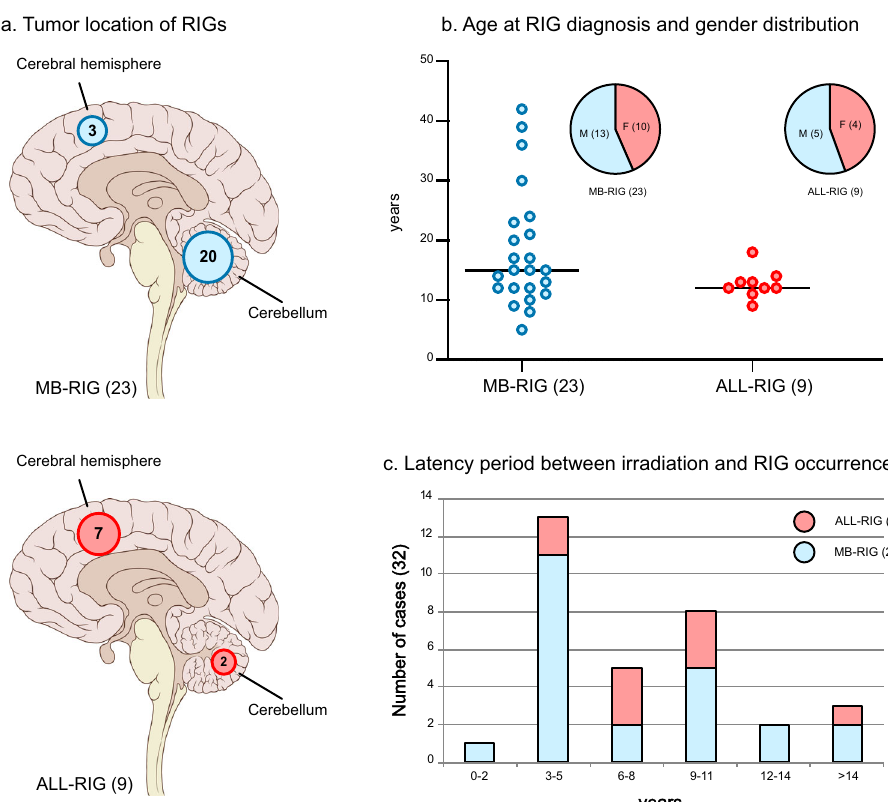
Fig. 1 Clinical patient characteristics. Tumor location for 23 MB-RIG and 9 ALL-RIG illustrated with circled numbers indicating the number of patients with RIG occurrence in the respective brain region ( a ). Signi fi cant differences in tumor location were observed between MB-RIG and ALL-RIG patients ( p < 0.01). Gender distributions, age at RIG diagnosis ( b ) and latency period ( c ) between cranial irradiation and RIG diagnosis are shown with numbers in brackets indicating group size. MB-RIG patients displayed a wider distribution regarding the age at RIG diagnosis and latency period. RIG radiation-induced glioma, MB-RIG post-medulloblastoma RIG, ALL-RIG post-ALL